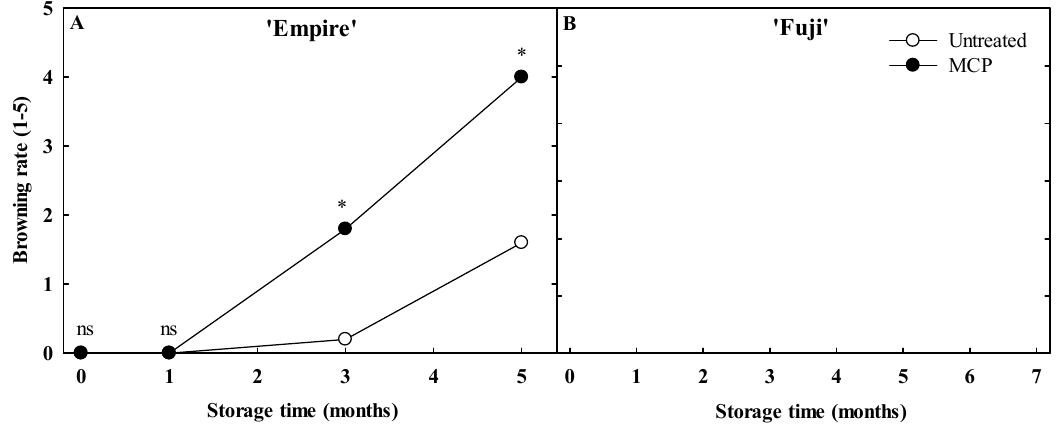
Figure 5. Incidence of browning of ‘Empire’ ( A ) and ‘Fuji’ ( B ) apples, either untreated or treated with 1 µL·L − 1 1-MCP, and stored at 0.5 °C in air storage for up to five and seven months, respectively. Bars represent error of the means (S.E.M; n = 5) when larger than the dimension of the symbol. ns and * indicate non-significant and significant differences between untreated and 1-MCP treatments at p < 0.05, respectively